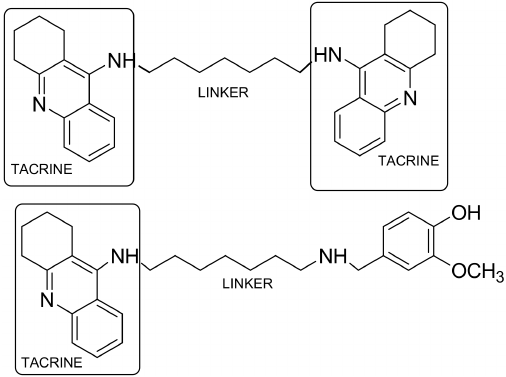
Figure 4. Tacrine homo- and